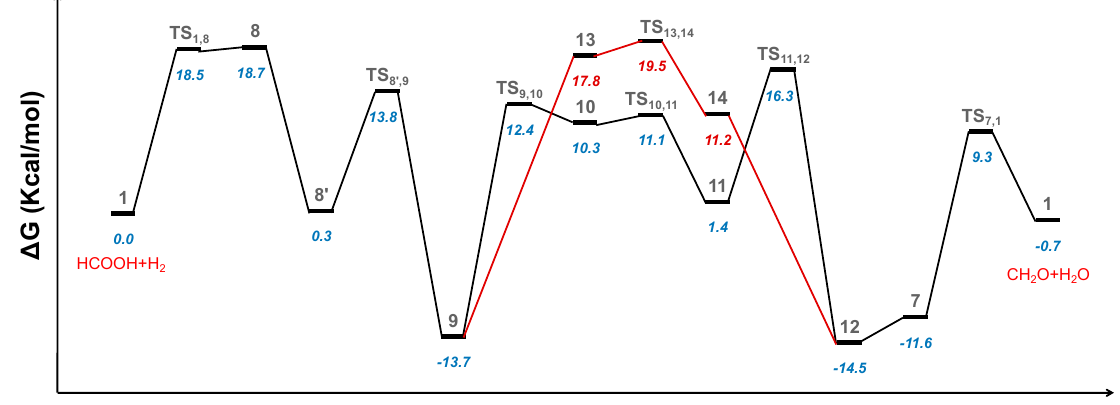
Figure 5. Free energy profile for the hydrogenation of formic acid to formaldehyde and water catalyzed by 1 (Cycle 2). Solvent corrected relative free energies are shown in italic. The deprotonation pathway is shown in red.